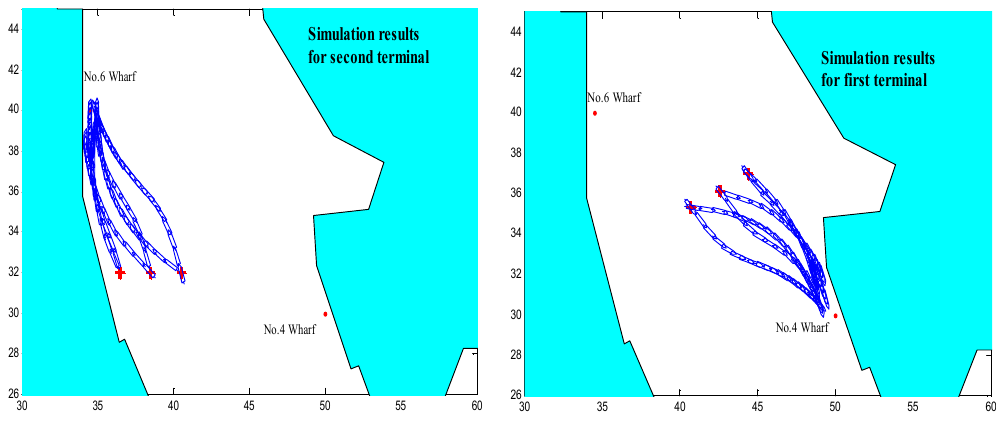
Figure 12. Gamcheon area of the Busan port for ship berthing.